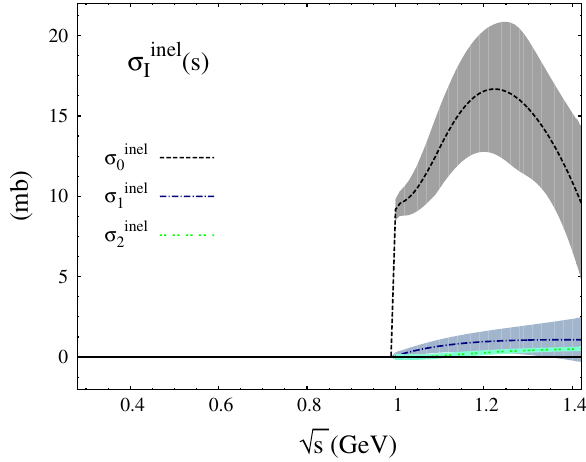
Fig. 9 Inelastic cross-section in the different isospin channels as a function of the CM energy below